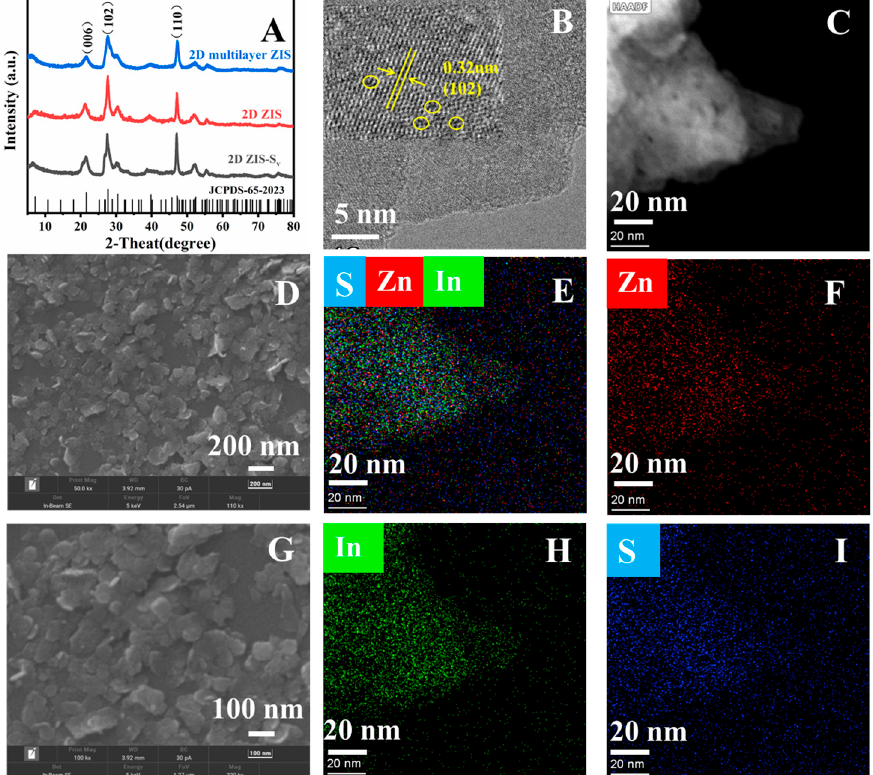
Figure 1. XRD patterns ( A ), SEM ( D , G ), HRTEM ( B ), and the STEM ( C ), elemental mappings ( E ) of Zn ( F ), In ( H ) and S ( I ) of 2D ZIS ‐ S v .